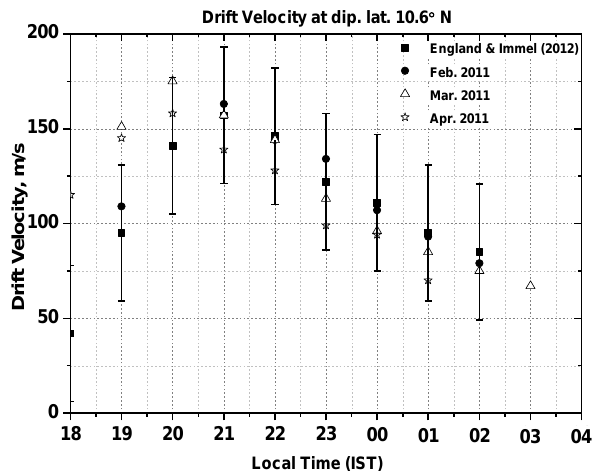
Fig. 7. The monthly mean zonal drift velocities of EPBs compared with values of empirical model for the months of February, March and April 2011.